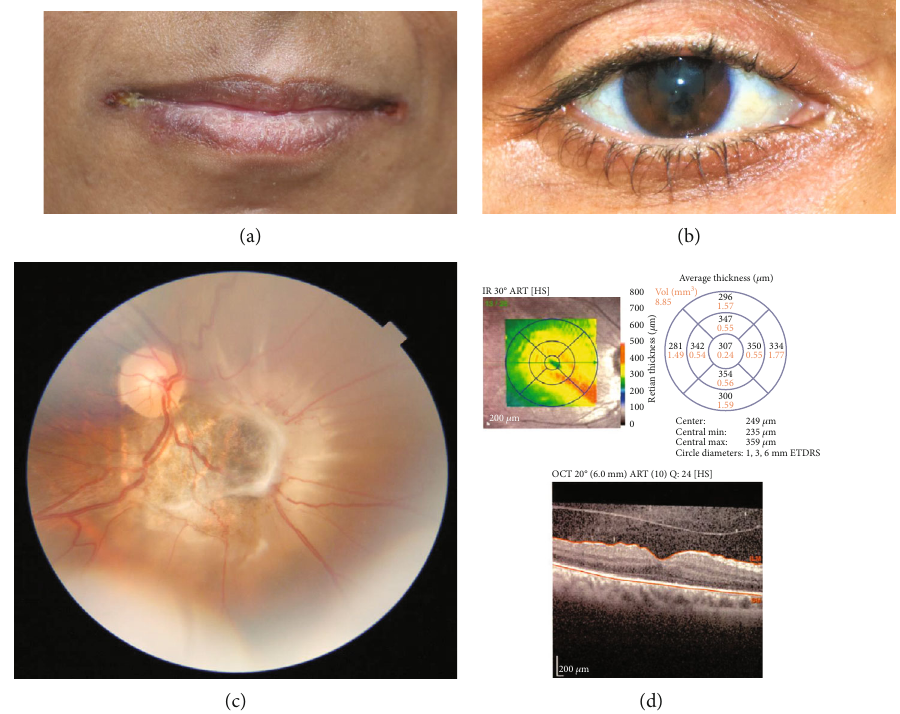
Figure 1: Clinical features of the patient at the time of presentation. Bilateral angular cheilitis (a), posterior synechiae, and keyhole-shaped pupil (b), In the right eye inferonasal to the optic disc, an annular white patch centered with a pigmented scar is seen. White subretinal bands are extending from the lesion. The size of the lesion is about three-disc diameter, and the adjacent retina is detached (c). Macular optical coherence tomography of the right eye demonstrates evidence of vitritis, detached posterior hyaloid, and a fi ne epiretinal membrane nasal to the fovea